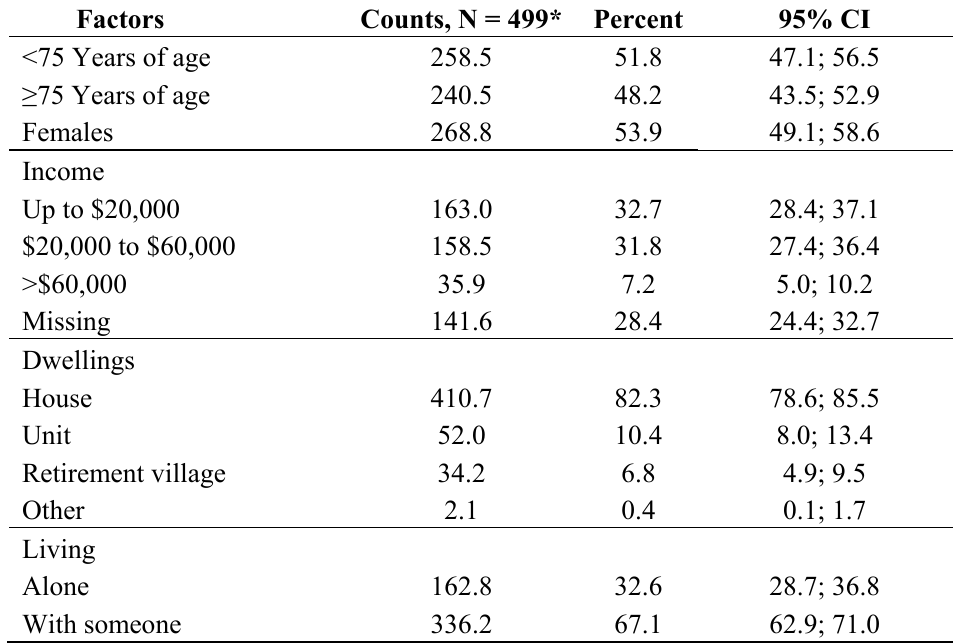
Table 1. Demographic outcomes and potential heat health risk factors (environment, socio-economic and health status). Weighted counts, percent and 95%